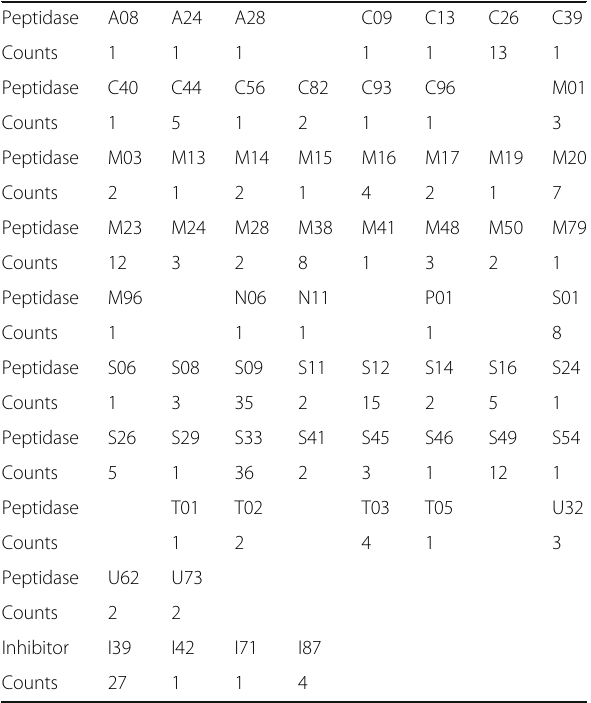
Table 6 Peptidases and simple peptidase inhibitors in